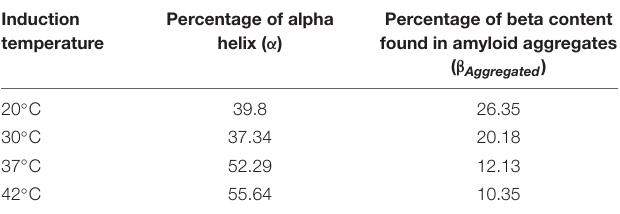
TABLE 2 | Percentage of alpha helical structure and beta sheet component from amyloid aggregates in asparaginase inclusion bodies expressed at different temperatures.